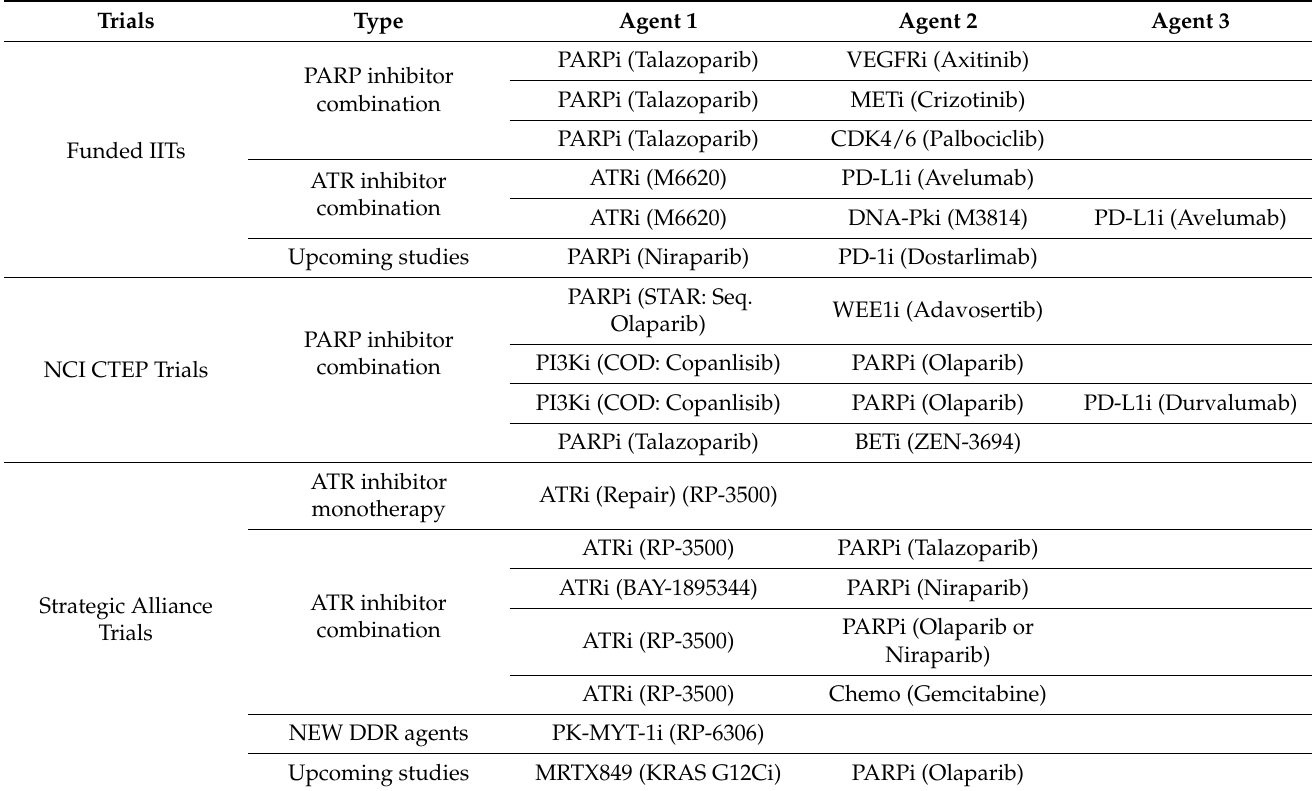
Table 3. Targeted therapy agents involved in Phase I trials for proteins affected by DDR